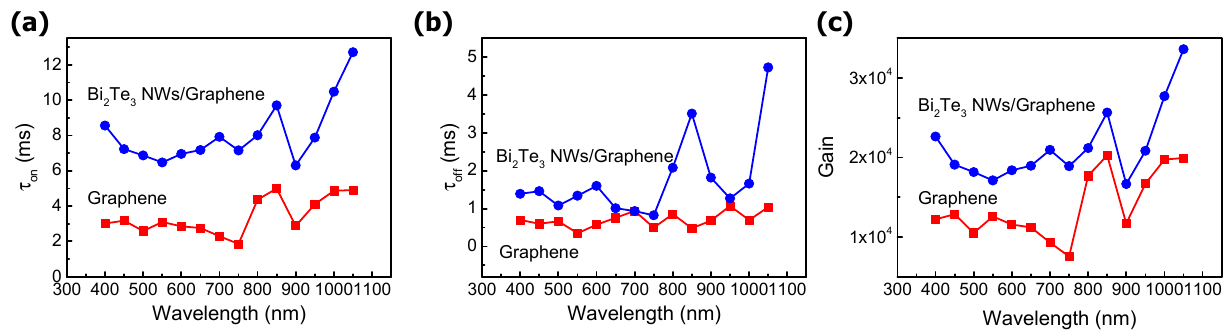
Figure 5. Carrier lifetime result for both the Bi 2 Te 3 NWs/graphene and graphene only device. ( a ) τ on and ( b ) τ off constant. ( c ) A photoconductive gain of both device structures. The measured wavelength range is from 400 to 900 nm.